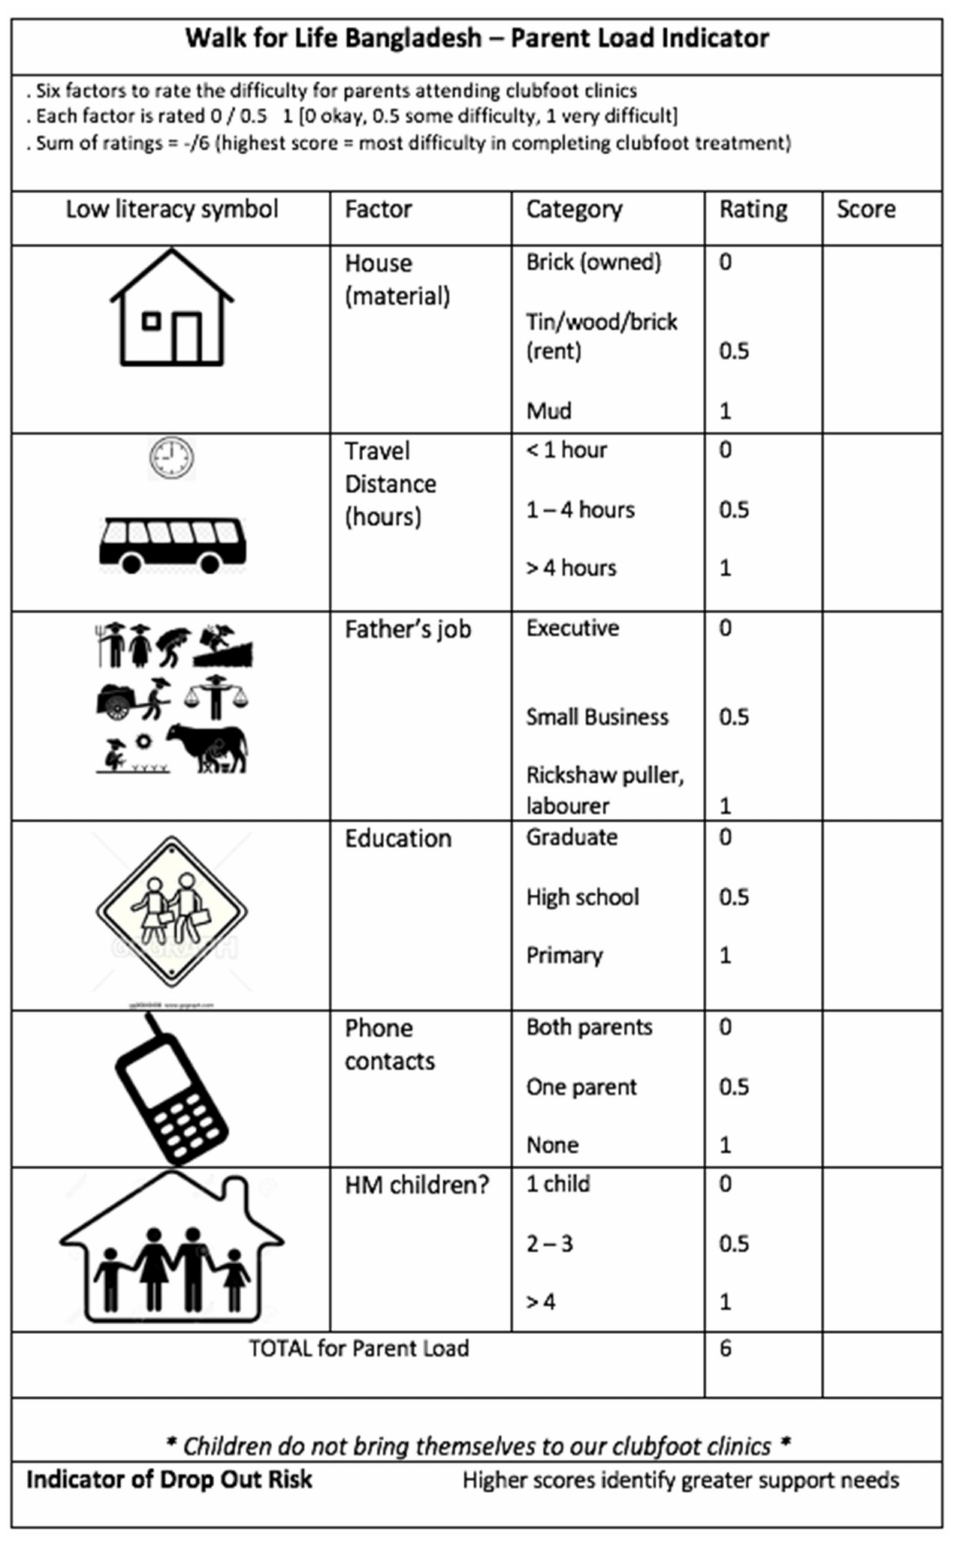
Figure 2. Initial parent load can be rated simultaneously to initial clubfoot severity